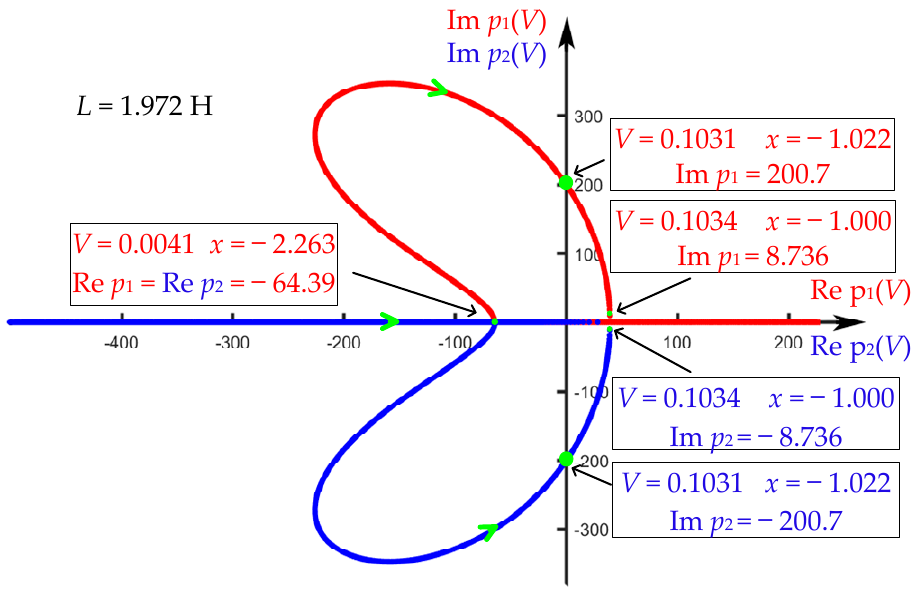
Figure 15. Variation in the real and imaginary parts of the poles of the admittance function in the series inductance oscillation circuit with the DC voltage.